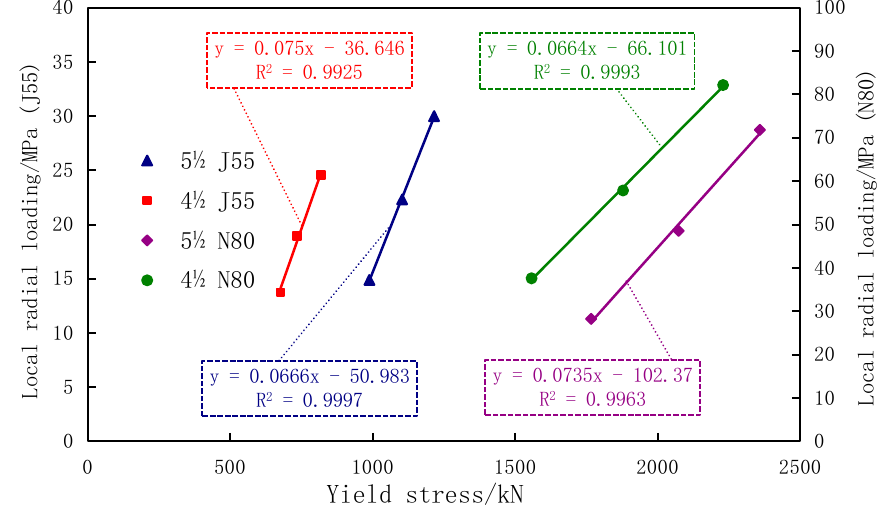
Figure 23. Relation curve between local radial loading and yield stress.